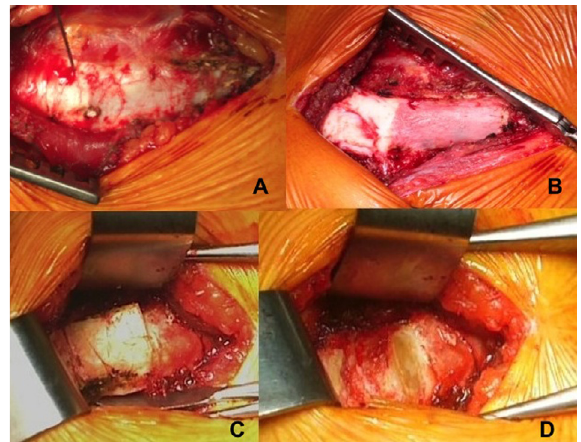
Figure 3. The osteochondral junction is easy to identify: after anterior surgical approach of the 8th rib (A), cartilage is white and soft and can be resected easely, the osseous part is pink (B) and has to be cut with a saw (C). Surgical site after ablation of the graft